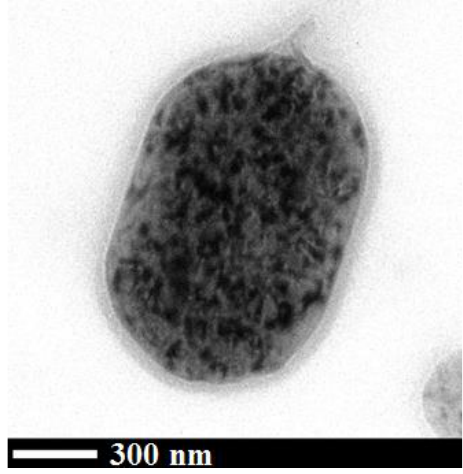
Figure 5. TEM image of 1/8 Cur-PVP sample.